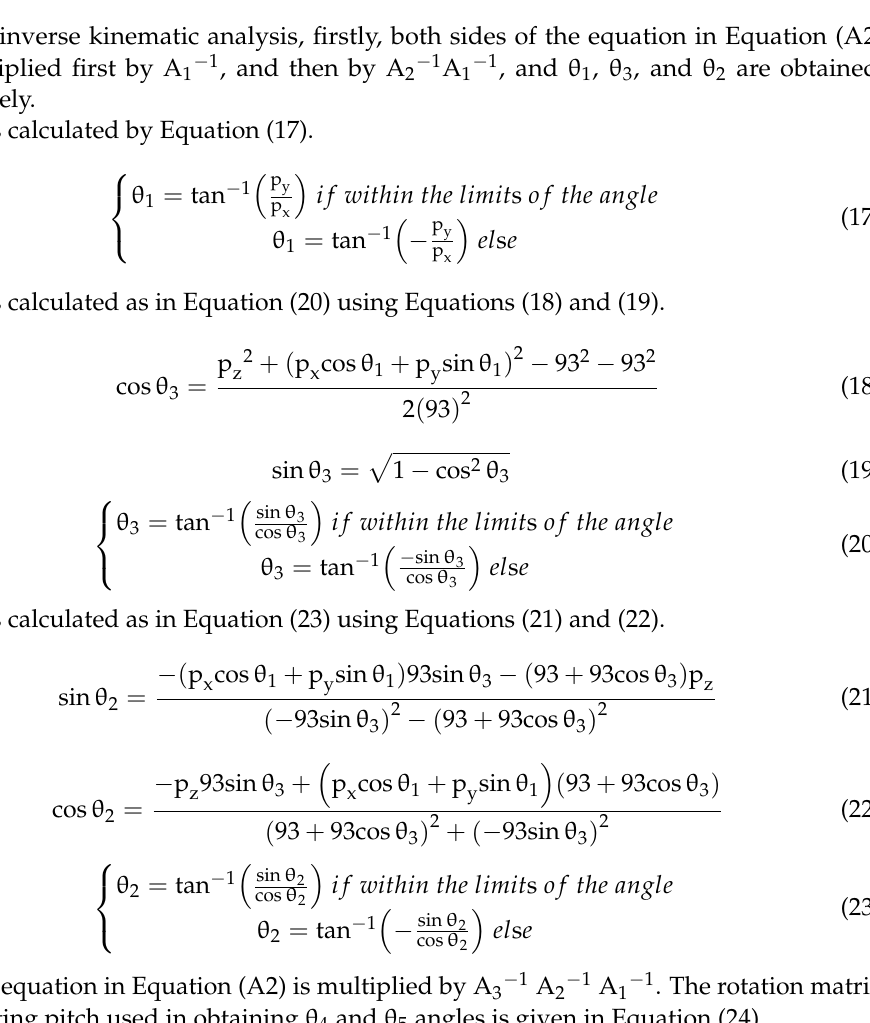
Table 2. Joint angle limits of Robotis-OP2 legs [55]. Limits of Joint Angle (Degree) Right Leg Left Leg Selected Limits Joint min. max. min. max. min. max. Ankle ( roll ) θ 1 − 39 60 − 58 34 − 58 34 Ankle ( pitch ) θ 2 − 71 78 − 79 70 − 79 70 Knee θ 3 0 128 − 129 0 0 128 Hip ( pitch ) θ 4 − 101 25 − 28 96 − 96 25 Hip ( roll ) θ 5 − 57 58 − 57 53 − 57